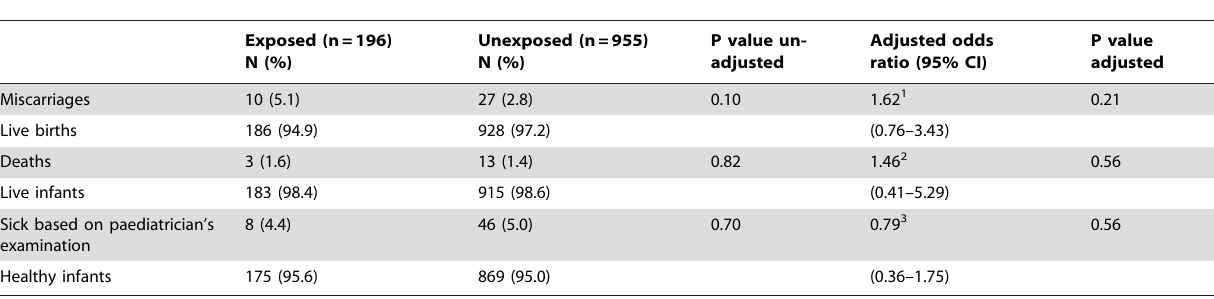
Table 1. Adjusted odds ratio of exposure to vaccine for negative outcomes using logistic regression models.